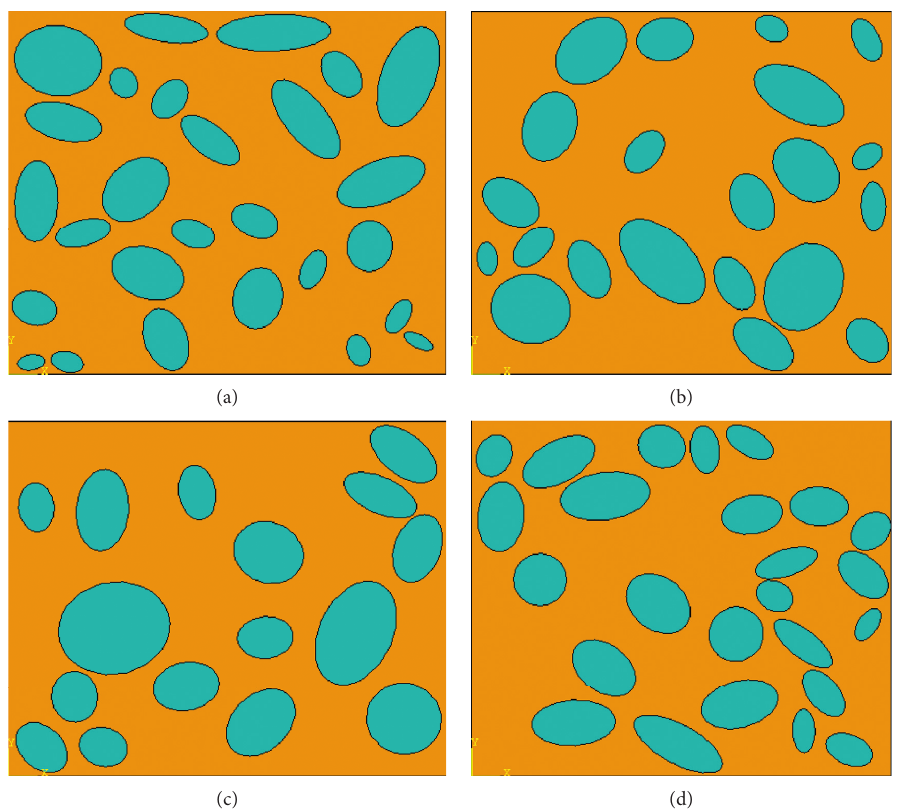
Figure 12: Simulation model of the uniaxial compression test with circular pores: (a) simulation model 5, (b) simulation model 6, (c) simulation model 7, and (d) simulation model